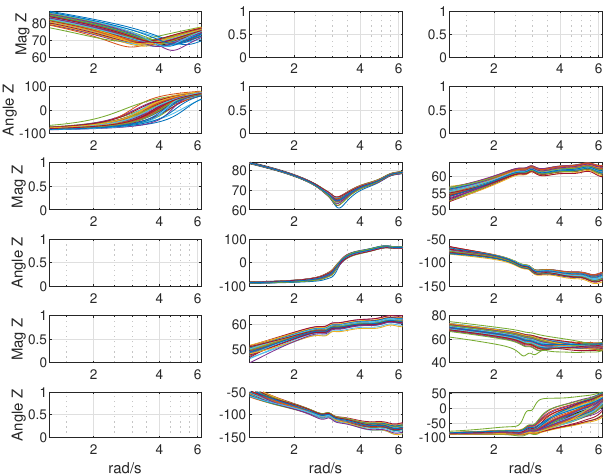
Fig. 10: Fifty realizations of impedance model Z error with 20% uncertainties on inertia, spring, and damping